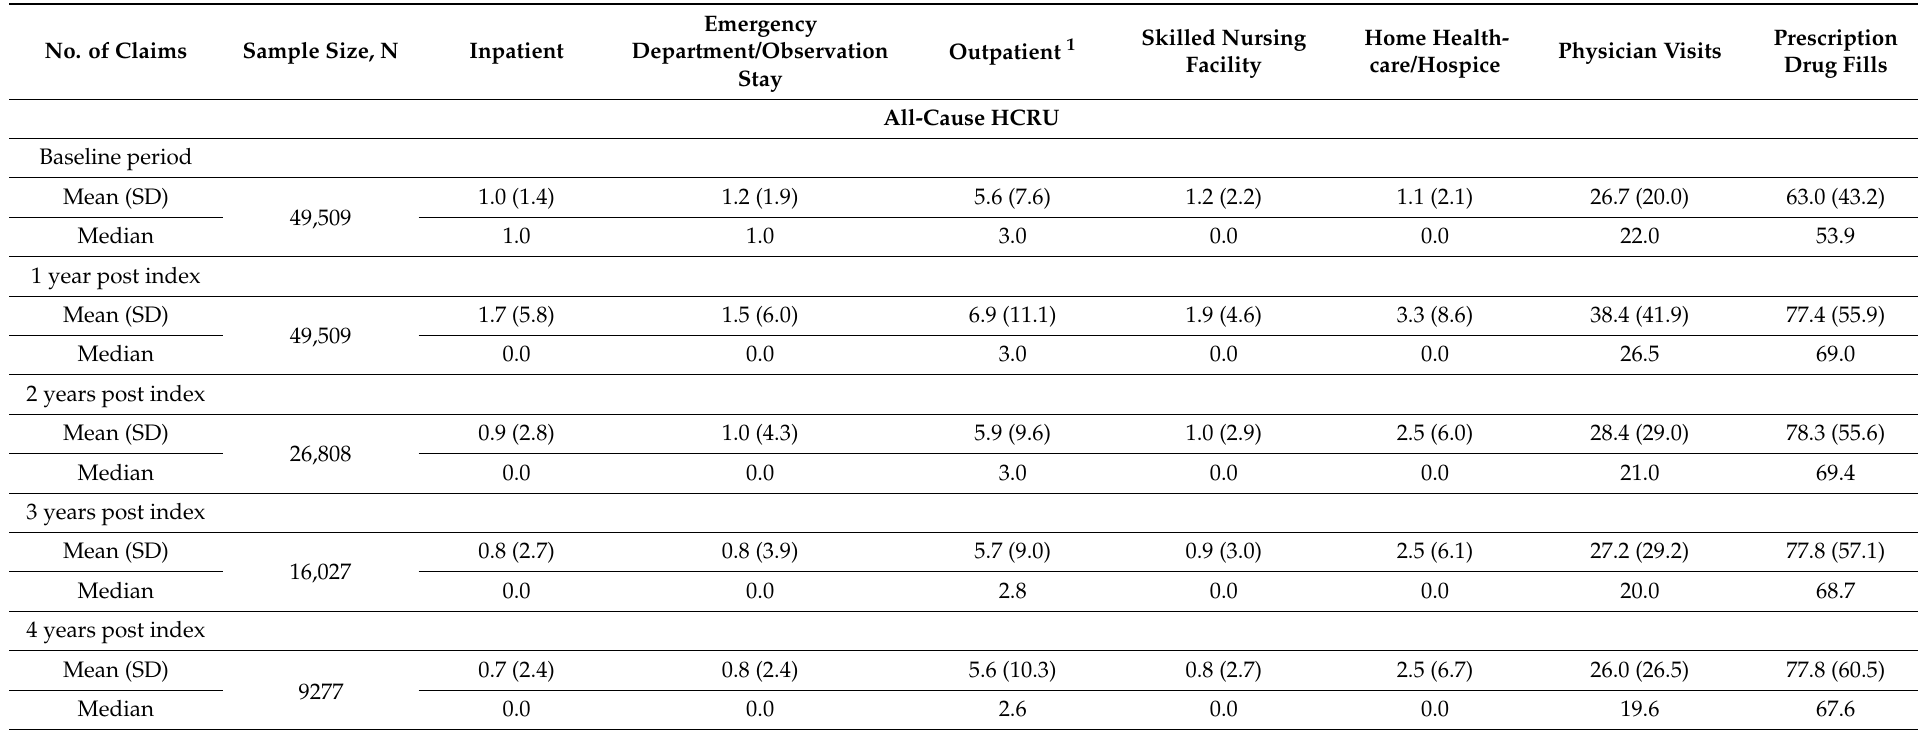
Table 1. Annualized all-cause unweighted HCRU claims per patient per year for patients with dementia-related psychosis.